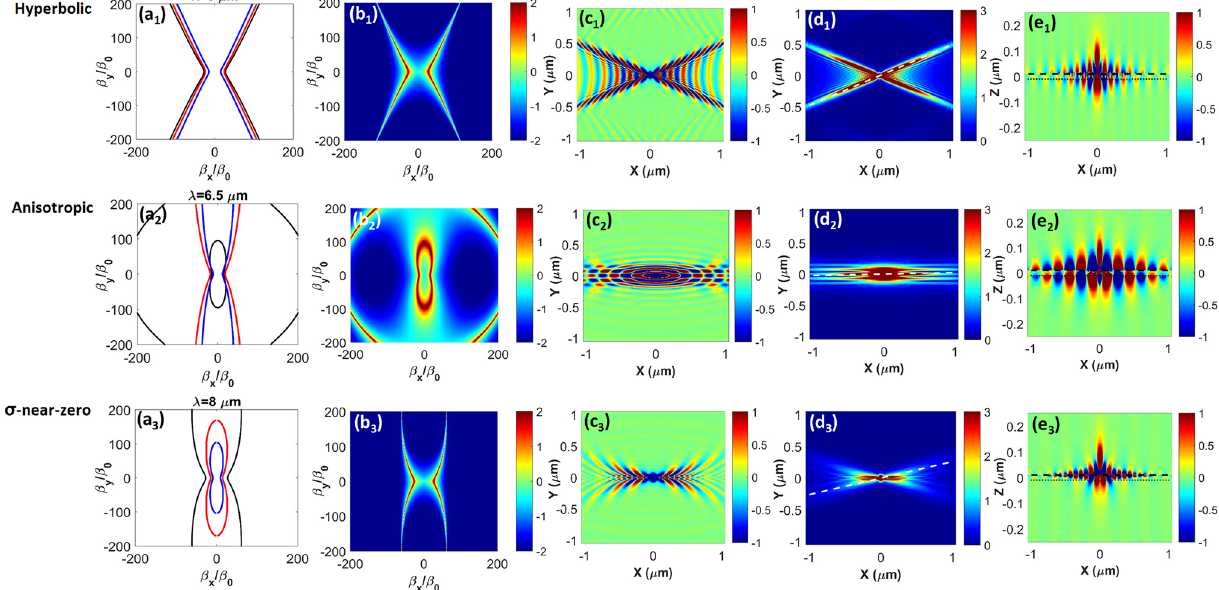
Figure 3: (a i ) EFCs, (b i ) transmission coef fi cients, and [(c i ) – (e i )] density plots of electric fi eld associated with the guided modes supported by the A2DM/hBN/sub structure[Figure 1(c)] with n (cid:1) 10 14 cm − 2 . The meaning of panels(c i ) – (e i ) is the same as in Figure 2. Black curves in (a i ) are the guided modes of the A2DM/hBN/sub structurewhereas blue and red curves correspond to the SP 2 s of the suspendedA2DM sheet and the A2DM/sub structure, respectively. Dotted horizontal line in (e i ) shows the interface between the hBN layer and the